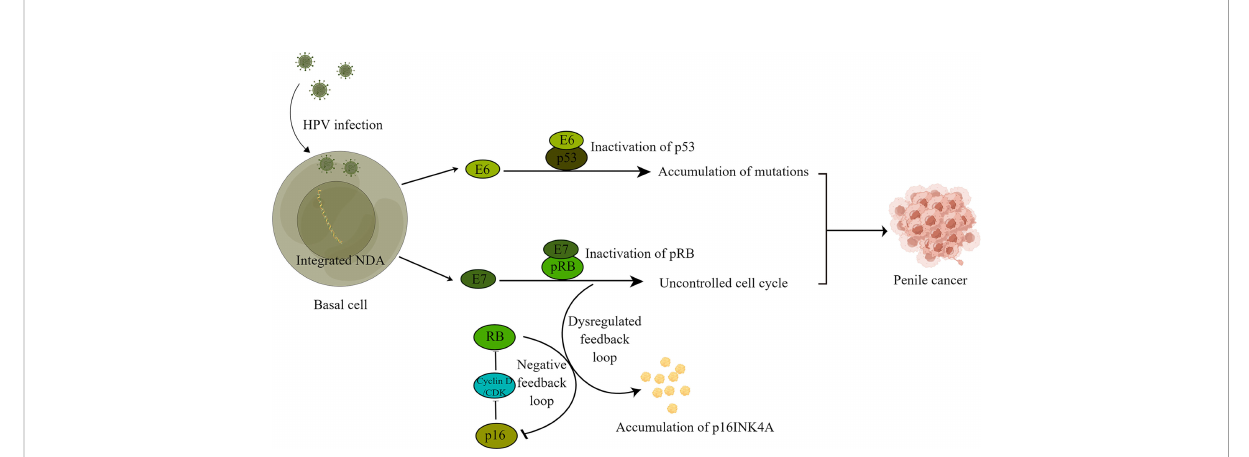
FIGURE 1 Carcinogenesis mechanism of HPV-mediated penile cancer. Human papillomavirus infects basal cells and integrates its own DNA into host DNA, resulting in high expression of viral oncoproteins E6 and E7. High expression of E6 and E7 leads to the inactivation of retinoblastoma protein (pRB) and p53, resulting in the accumulation of mutations and an uncontrolled cell cycle, ultimately leading to tumorigenesis. In addition, disruption of the negative feedback between p16INK4A and pRB due to the inactivation of pRB leads to high-level expression of p16INK4KA in penile